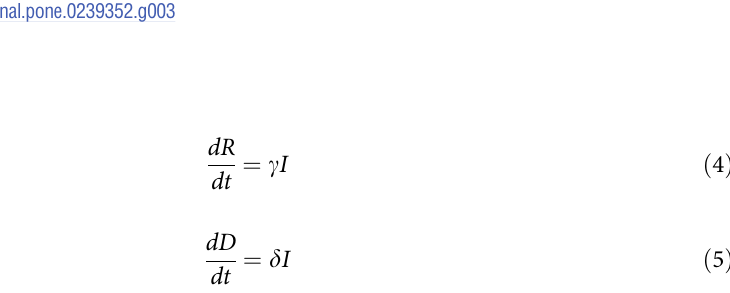
Fig 3. The SEIRD model flow chart. Legend : This model shows how, beginning from S, the susceptible population moves from being exposed E, to infected I, and then to either recovery R, or death D, the movement being regulated by different